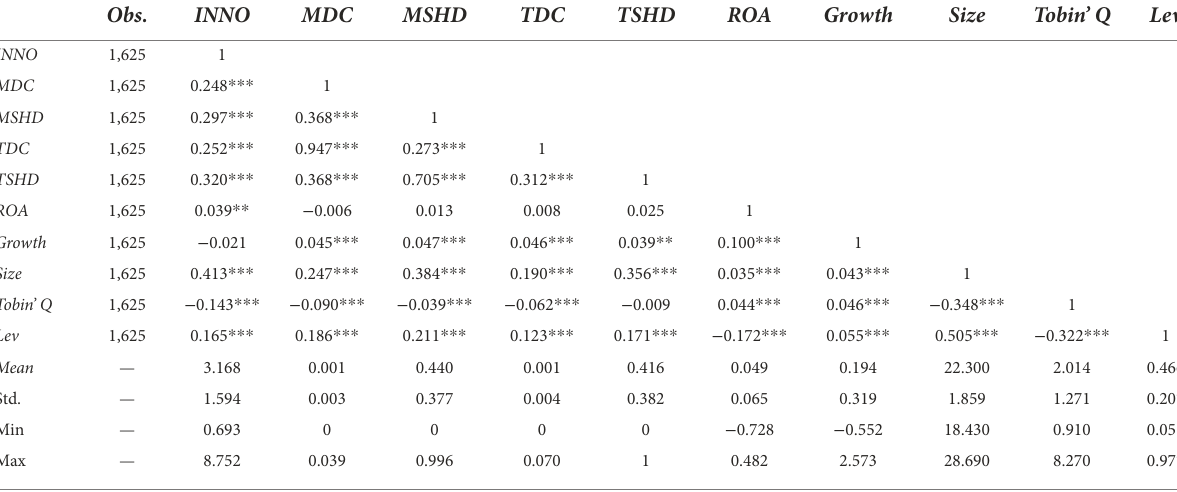
TABLE 2 The descriptive statistics and correlation analysis of the main variables.